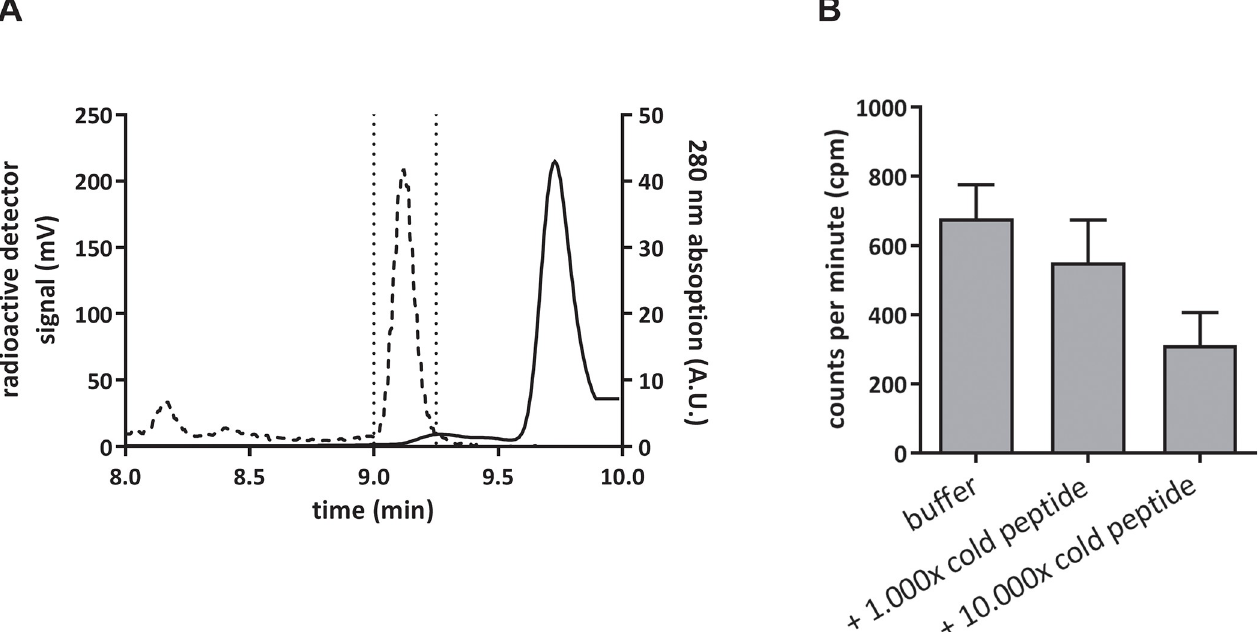
Fig 2. A Reverse-phase HPLC chromatogram of a 68 Ga-DOTA-NAPamide purification. The dashed line shows the radiodetector signal and the peak there represents the 68 Ga-DOTA-NAPamide fraction, while the solid line shows the 280 nm absorption signal with the peak of DOTA-NAPamide. The area surrounded by dotted lines represents the purified fraction used in in vivo experiments. B In vitro displacement of 68 Ga-DOTA-NAPamide from B16/F1 cells by an excess of unlabeled DOTA-NAPamide (n = 3; mean +/- SEM). Differences were not statistically significant (p = 0.12, R 2 = 0.51, one-way ANOVA).